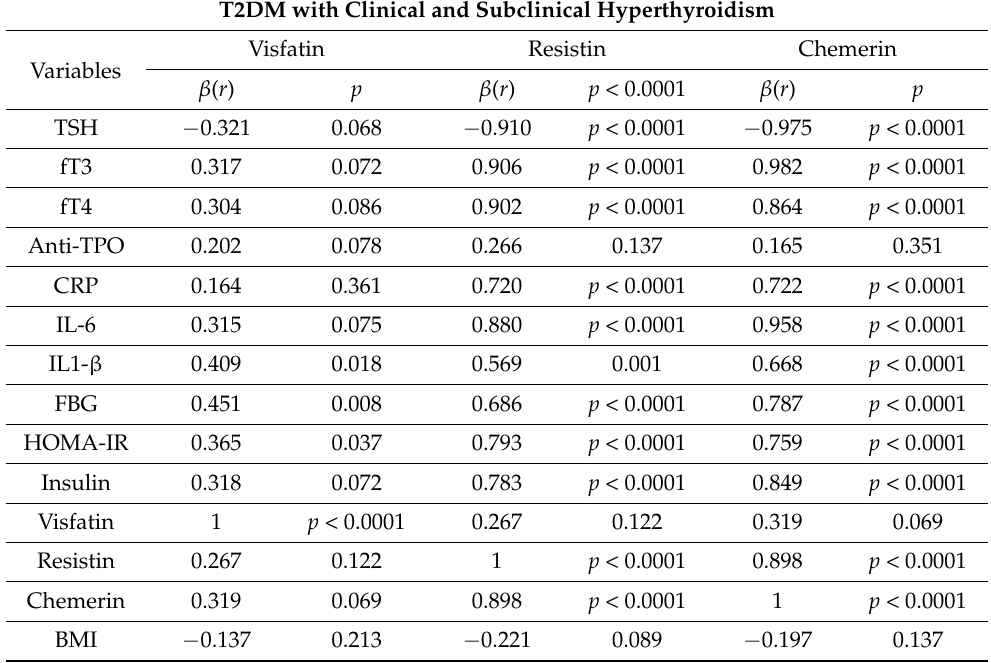
Table 4. Association between serum levels of adipocytokines and insulin-resistant markers, thyroid- hormone profile and inflammatory factors in T2DM patients coexisting with hyperthyroidism. T2DM with Clinical and Subclinical Hyperthyroidism Visfatin Resistin Variables